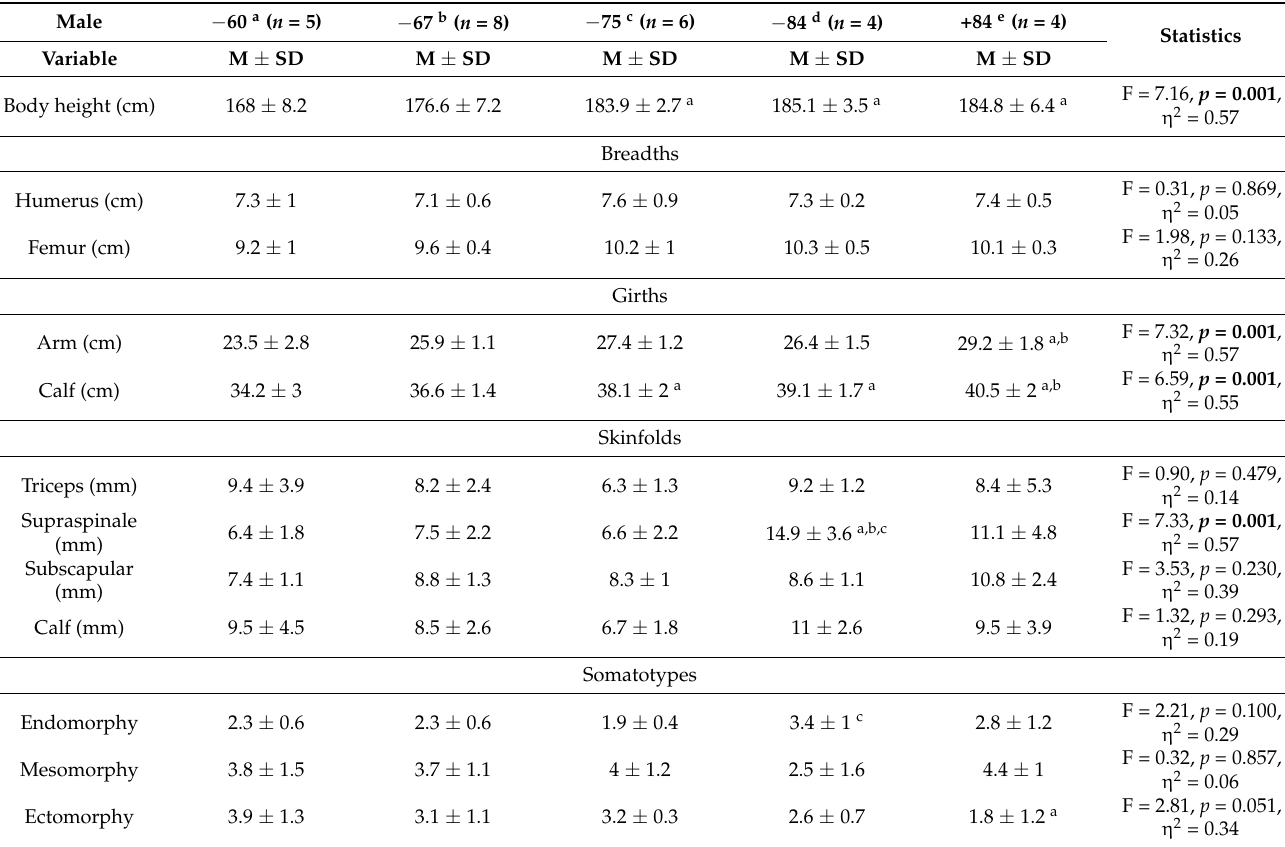
Table 1. Differences between weight categories of male